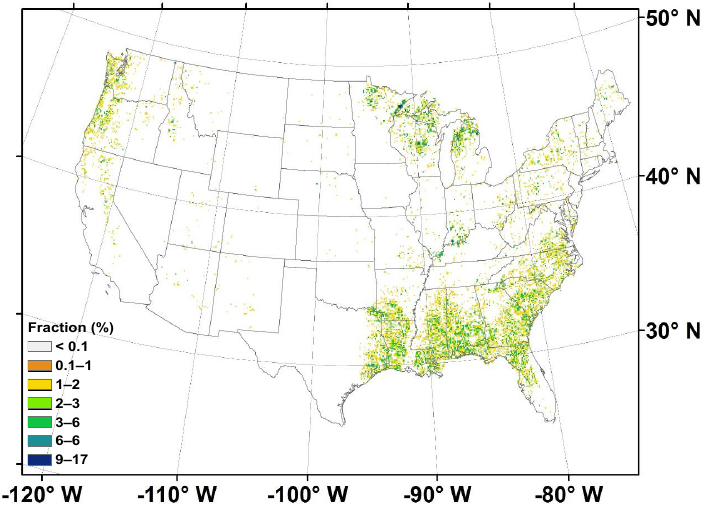
Figure 4. Fraction of the plots with plantation forests in the grid cells at a spatial resolution of 8km ×